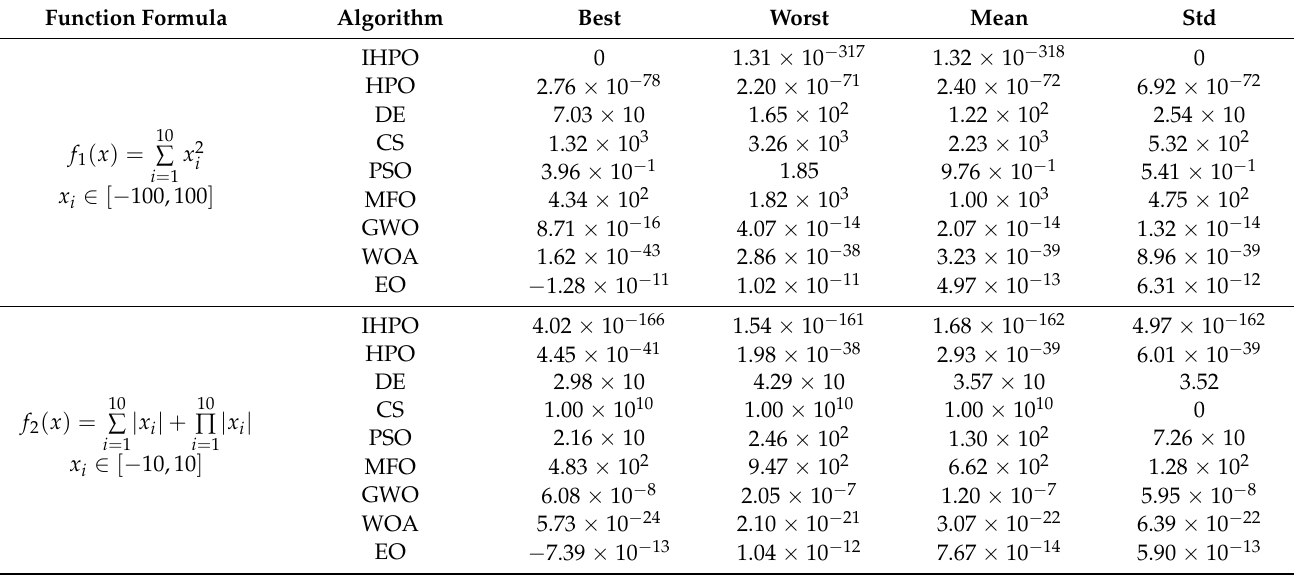
Figure 3. The figures and iteration curves of four test functions. ( a ) f 1 ( x ) ; ( b ) f 2 ( x ) ; ( c ) f 3 ( x ) ; and ( d ) f 4 ( x ) . Table 1. The statistical results of four test